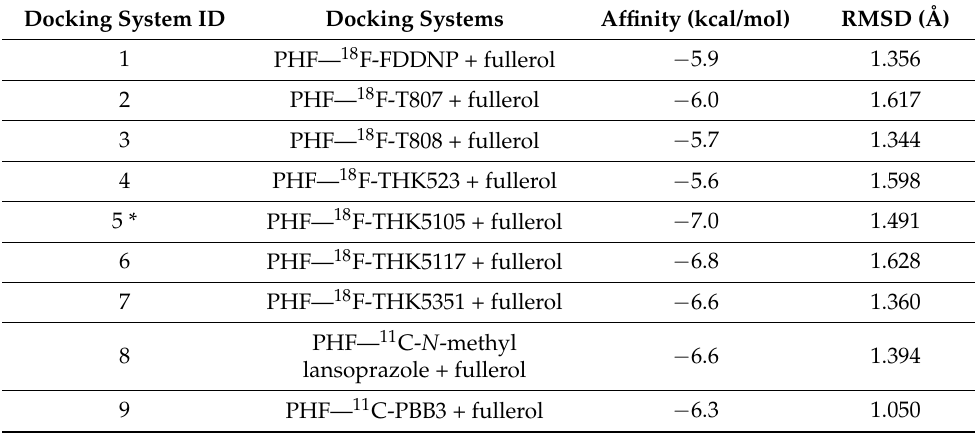
Table 1. Obtained free energy of binding (affinity; kcal/mol) and R.M.S.D (Å) for the best docking poses obtained of each PHF-ligand docking system evaluated and highlighting the best ranked docking system based on the free energy of binding (5: PHF— 18 F-THK5105 + fullerol) denoted by the label symbol